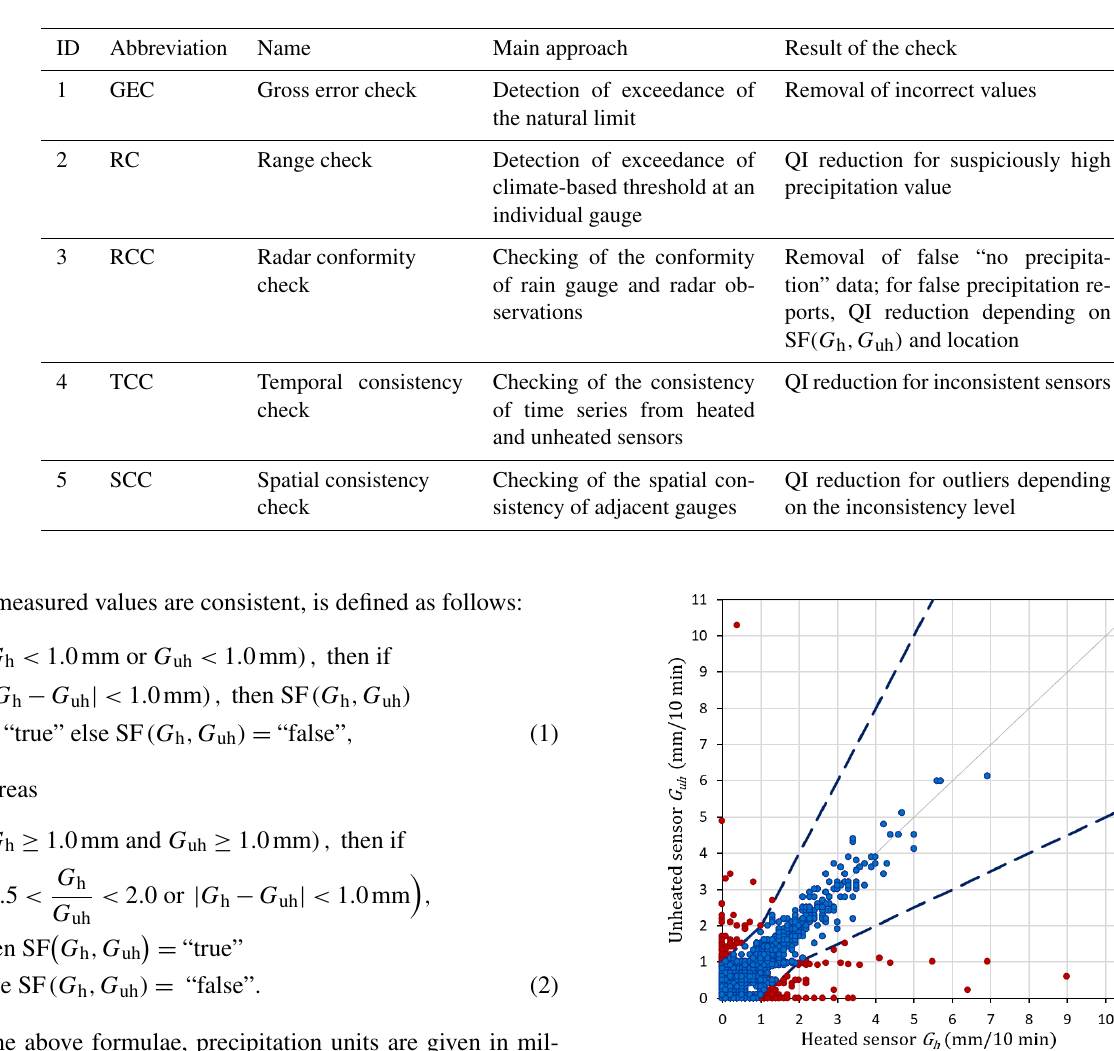
Table 1. List of sequential checks for precipitation QC.